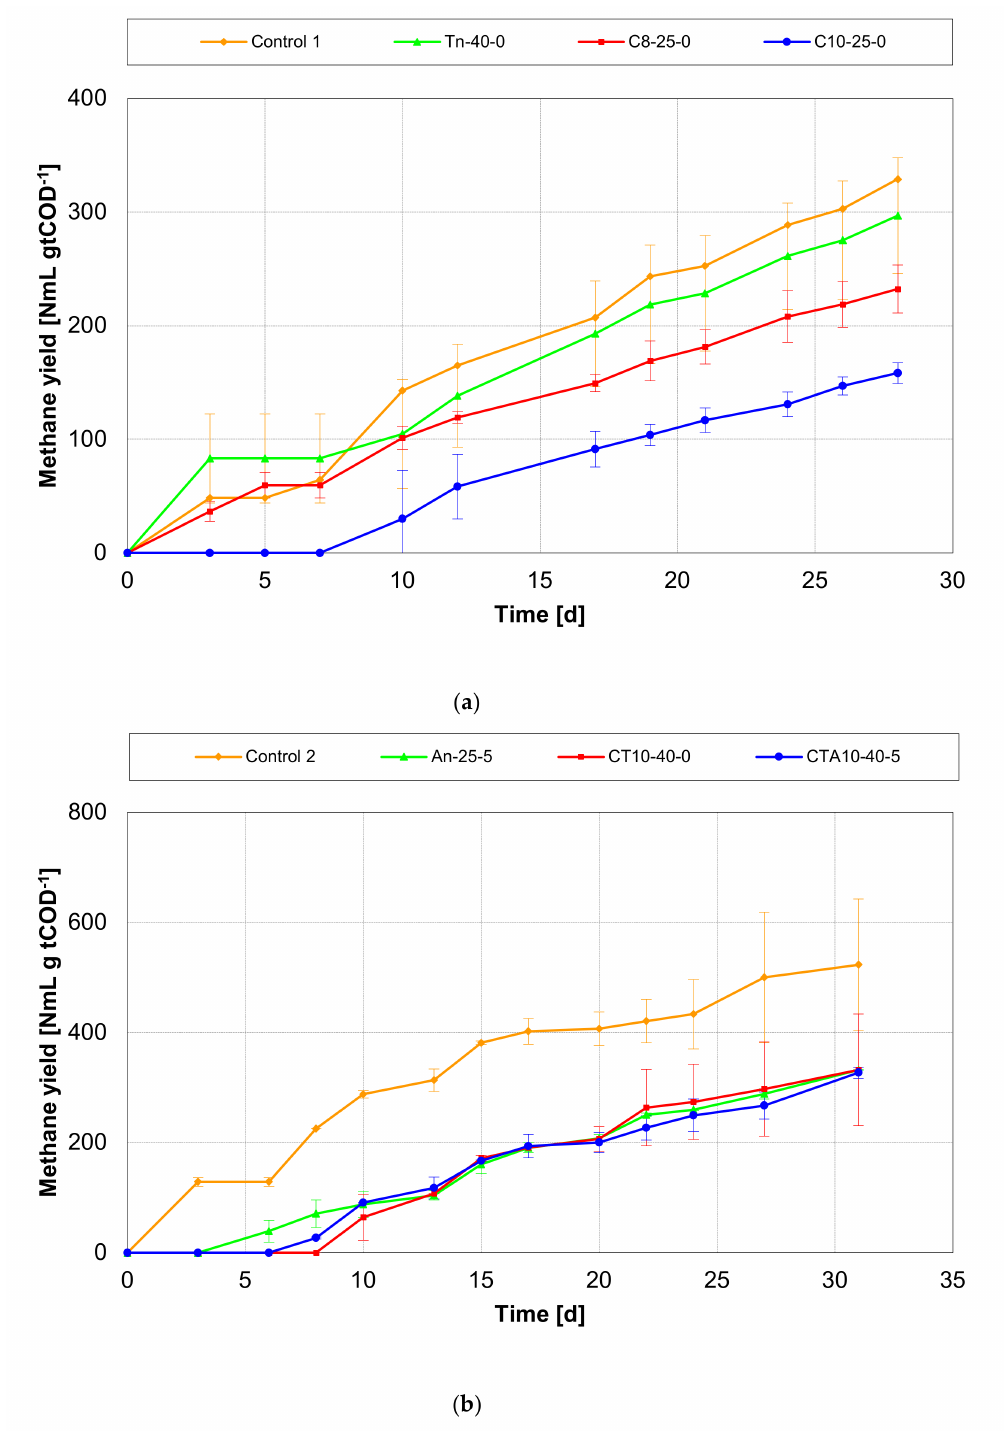
Figure 3. Specific methane production recorded in ( a ) Run 1 and ( b ) Run 2 of the BMP tests performed on pretreated SW. The capital letters of the tests indicate the treatment, and the three letters / numbers identify the value of the operational parameter, pH, temperature, and air flow rate; C = chemical; T = thermal; A = aerated; c = control; and tCOD = total COD. The error bars represent the standard deviations. The experiments were carried out in